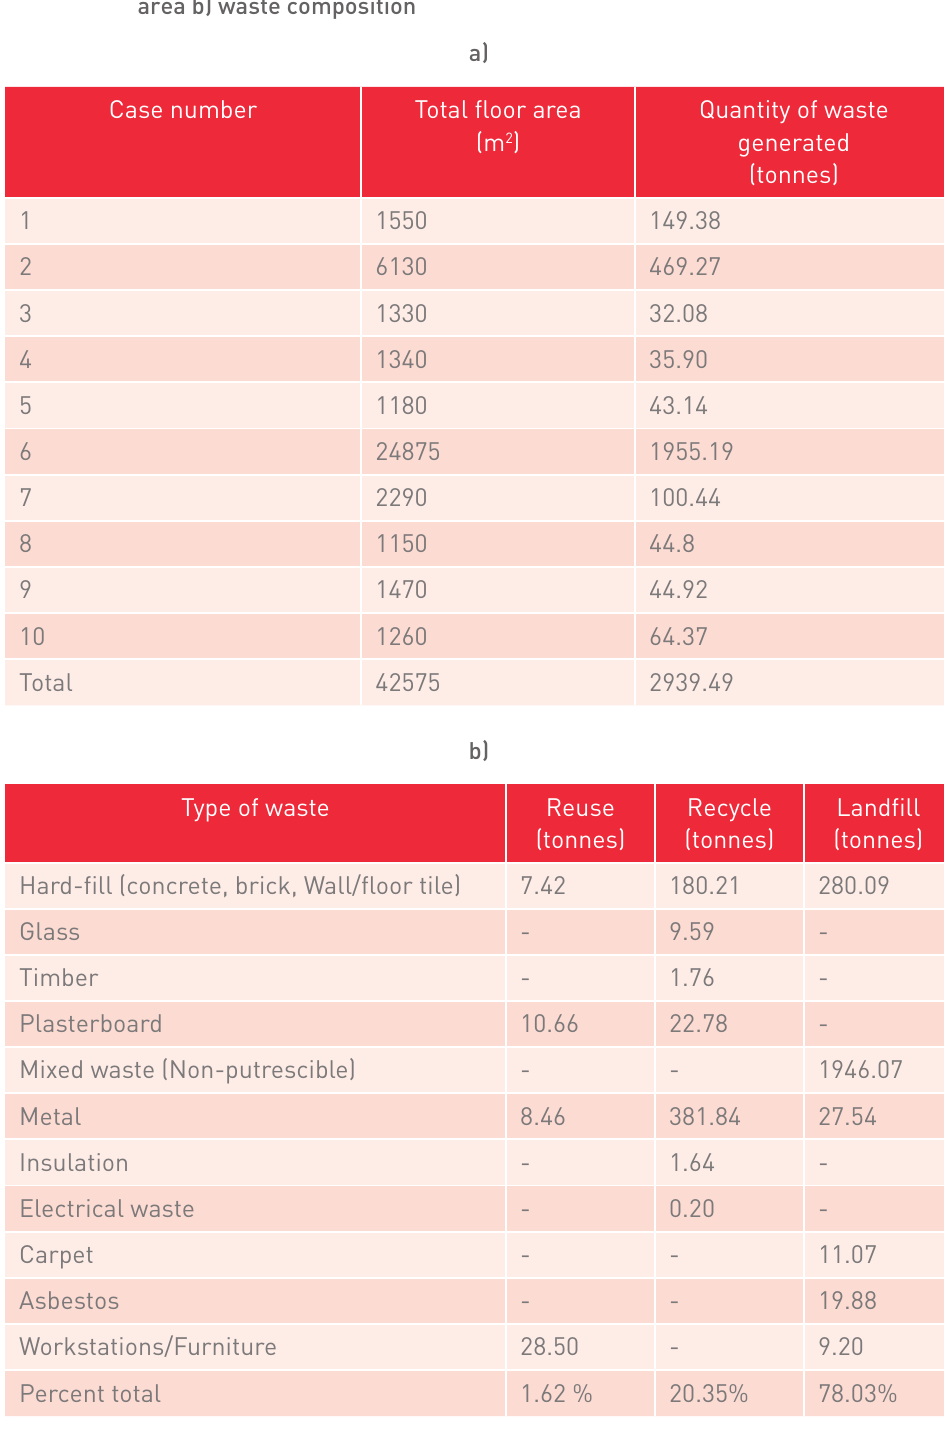
Case studies and their waste statistics a) waste summaries per case